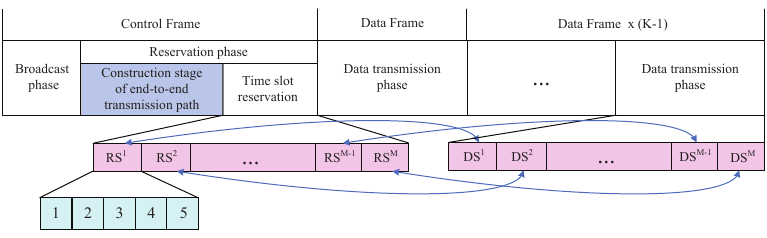
Figure 4. The corresponding relationship between reservation slot and data transmission